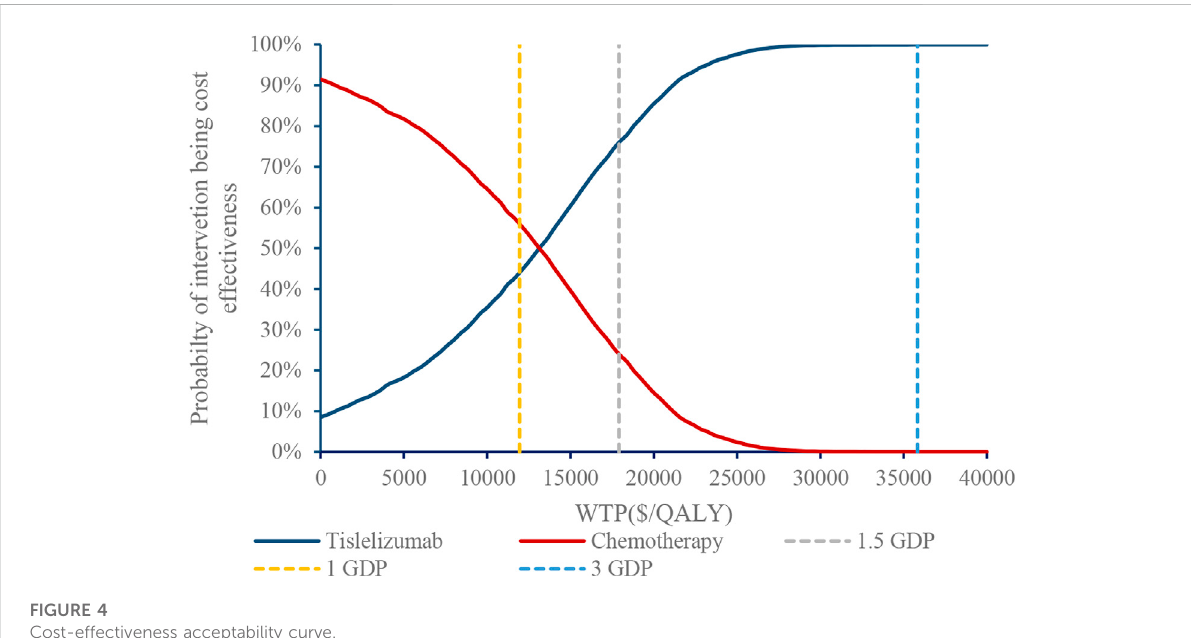
FIGURE 4 Cost-effectiveness acceptability